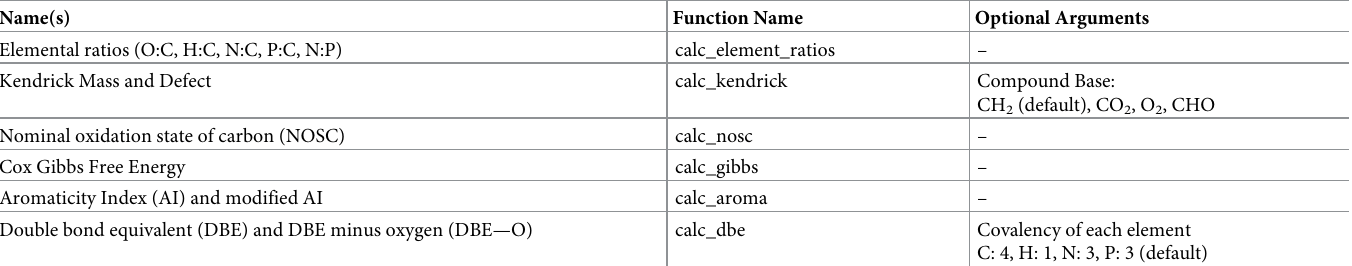
Table 2. Chemical property calculations available within